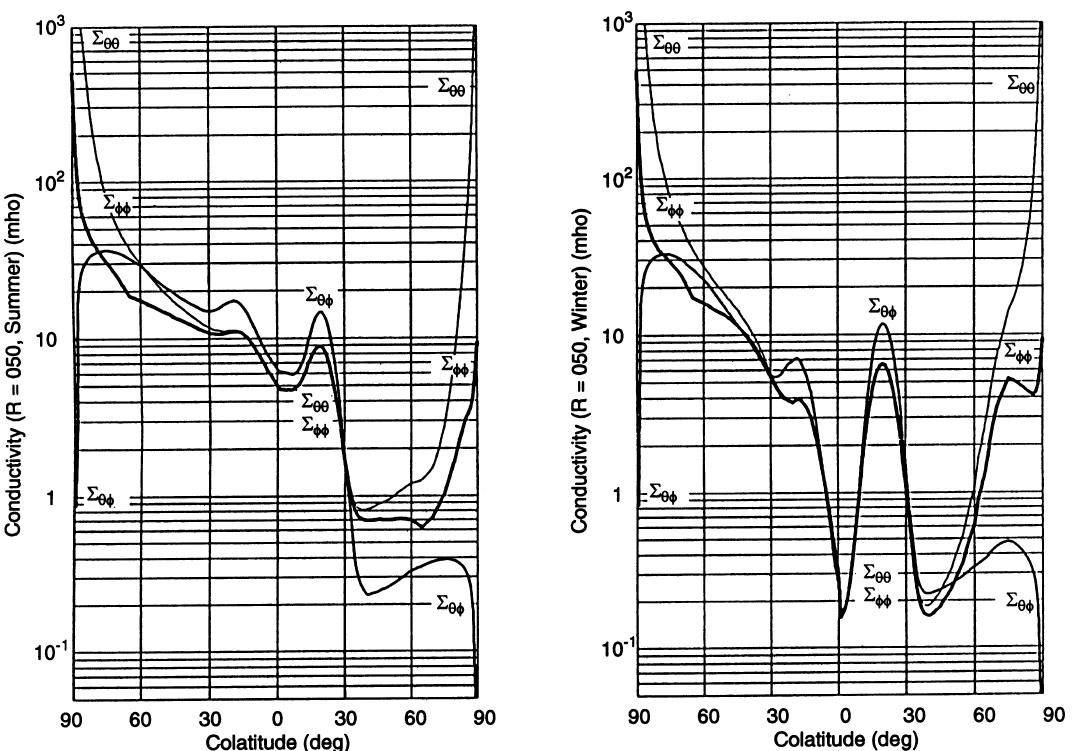
Fig. 8. Noon-midnight profiles of S and winter ( right ) solstices with sunspot number 50 for IRI parameters. The meanings of the labels and the plot style are as for Fig.